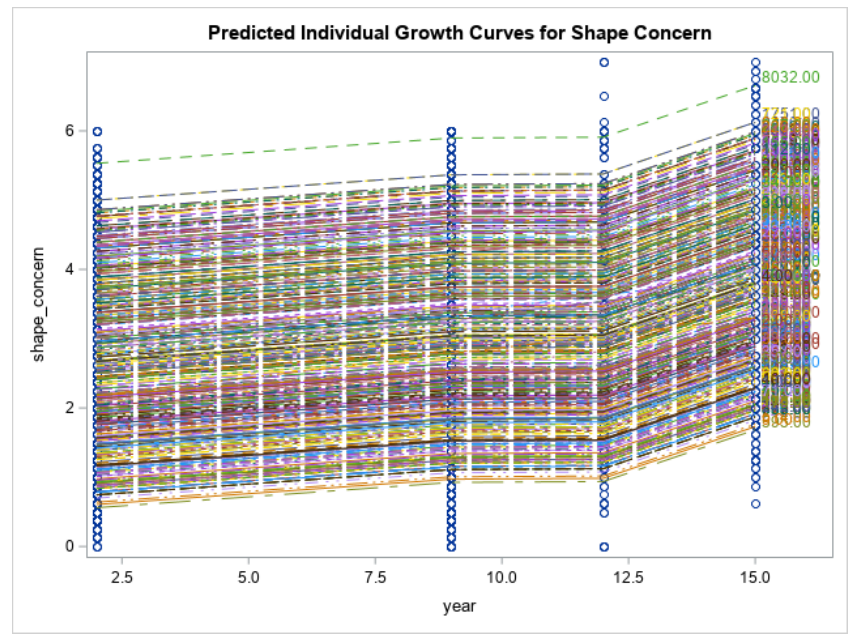
Figure 2. Predicted individual growth curves for shape concern. The blue lines indicate the measurement time points.